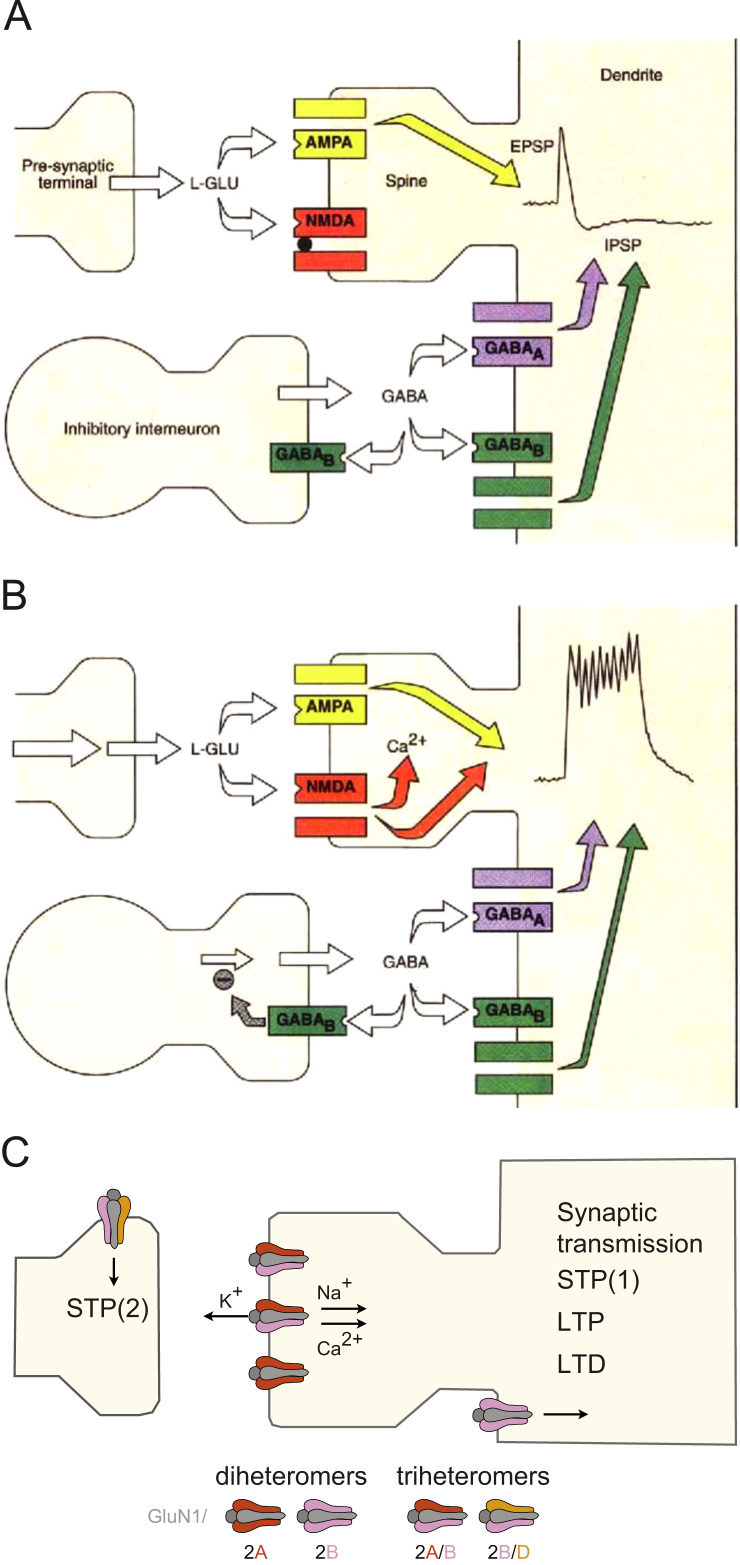
Various functions of NMDA receptors. (A) Release of glutamate during low frequency synaptic transmission leads to activation of AMPARs (EPSP) and sparse activation of NMDARs, which is insufficient to induce synaptic plasticity. The predominantly AMPAR-mediated EPSPs are shaped by GABAergic interneurons through GABA acting on GABAA and GABAB receptors (IPSP) that prevent over-activation of NMDARs (Bliss and Collingridge, 1993). (B) Release of glutamate during high-frequency synaptic transmission leads to activation of NMDARs due to relief of Mg2+ block. This happens because of summation of AMPAR-EPSPs, depolarisation that is mediated by build-up of extracellular K+ and GABAB auto-receptor mediated inhibition of GABA release (Bliss and Collingridge, 1993). (C) Activation of NMDARs triggers a variety of different forms of synaptic plasticity. STP is expressed presynaptically, as an increase in P(r). It comprises two components: STP(2) is induced via activation of GluN2B and 2D containing NMDARs (potentially as a triheteromer located on the presynaptic terminal). STP(1) is induced via activation of GluN2A/B receptors. These could be located postsynaptically and signal (together with AMPARs) to the presynaptic terminal via their flux of K+ (Collingridge, 1992; Park et al., 2014; Shih et al., 2013). LTP is induced via activation of GluN2A and GluN2B receptors, with a triheteromer being the dominant species. LTD may involve different subtypes of NMDAR, including diheteromeric GluN2B receptors (Liu et al., 2004).